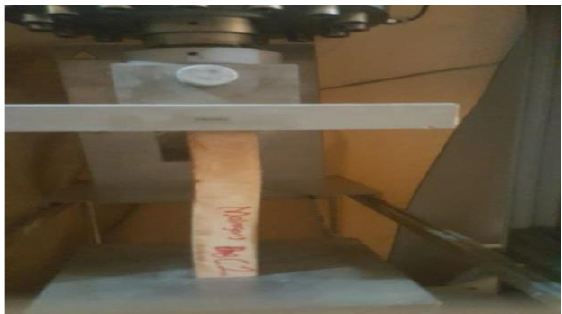
Fig. 2. Failure mode Mahogany